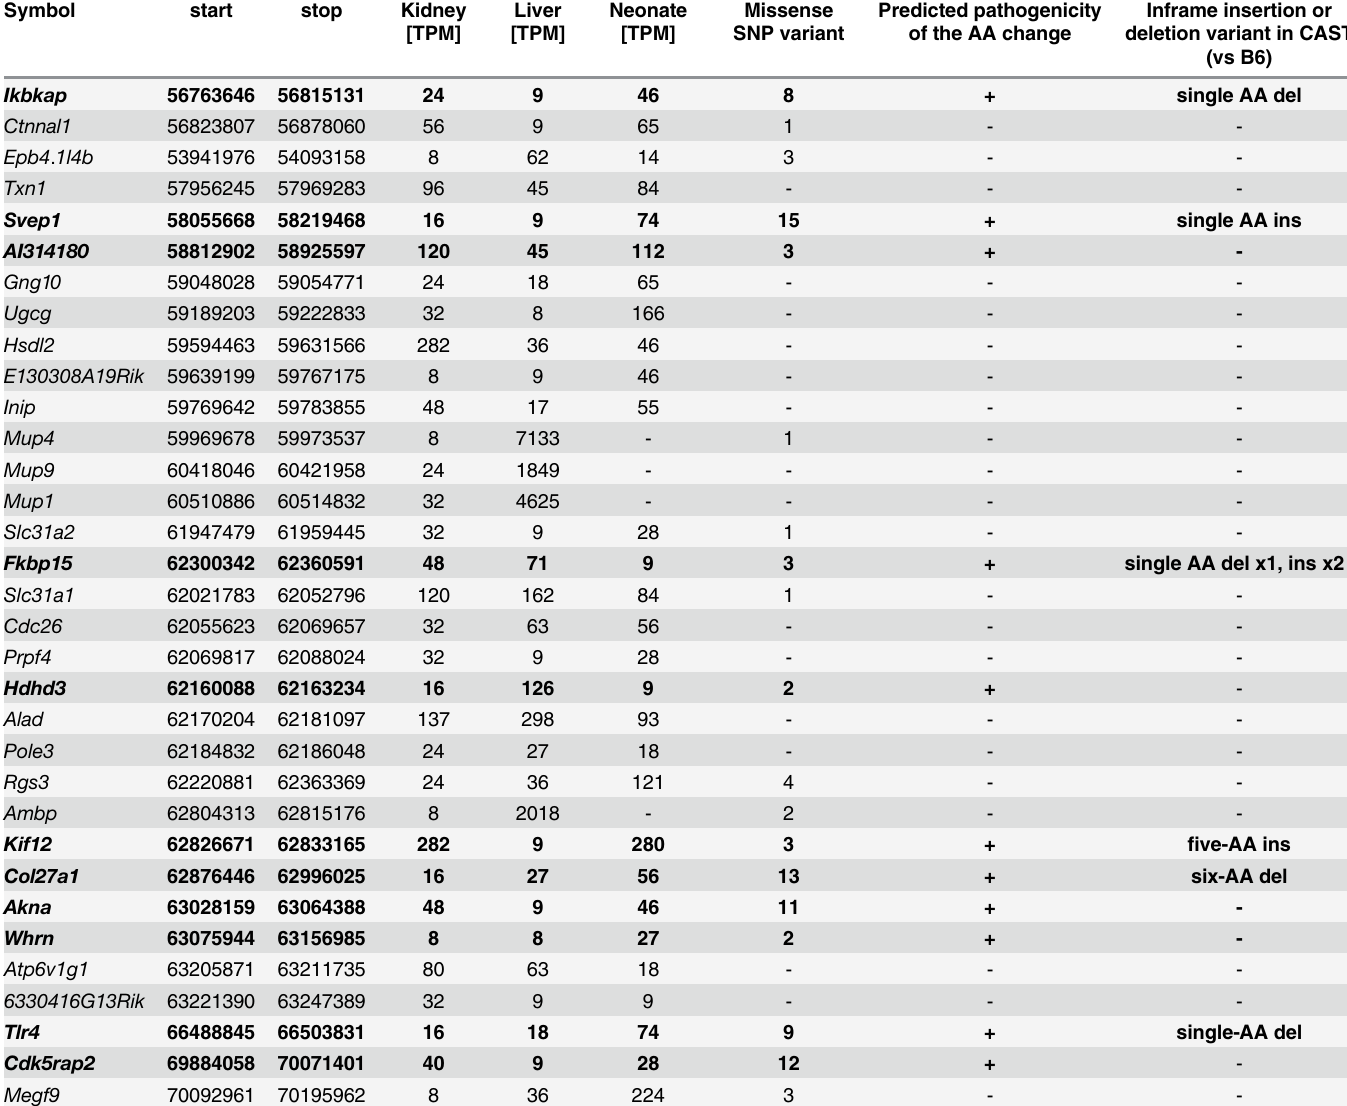
Table 2. Positional candidates for Mpkd2 effects: a subset expressed in kidney and